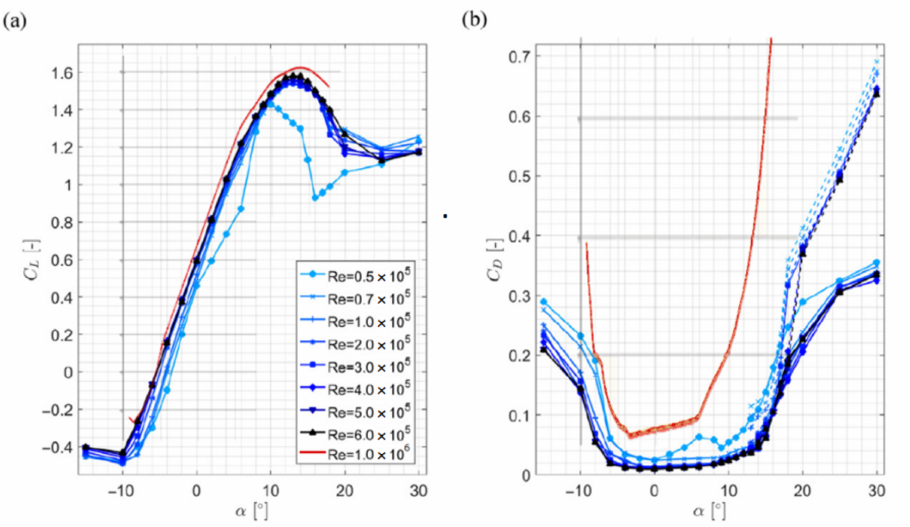
Figure 5. NREL Lift (C L , ( a )) and drag (C D , ( b )) coefficients vs. angle of attack ( α ) of NREL S826; experimental data for Re = 0.5 · 10 5 to Re = 6.0 · 10 5 [41] and Re = 1.0 · 10 6